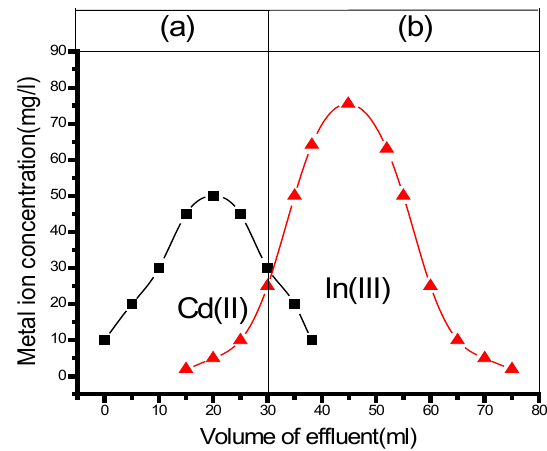
and (b) 1 M HNO . 3 3